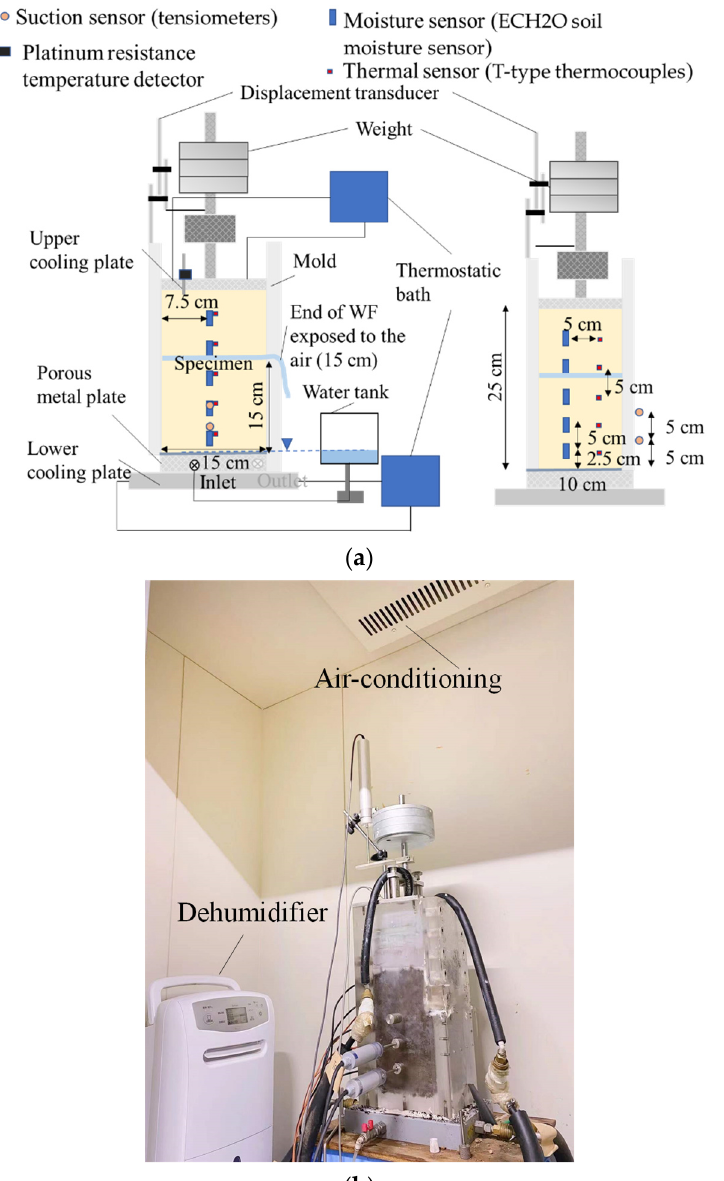
Figure 4. Frost heave model test. ( a ) Schematic of the test apparatus. ( b ) Picture of the test setup.